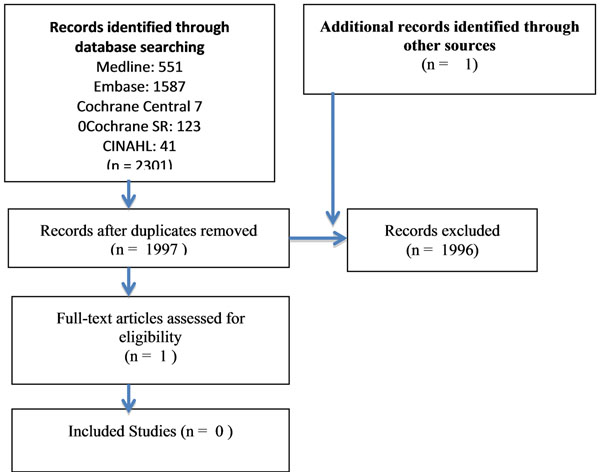
Search Flow Diagram